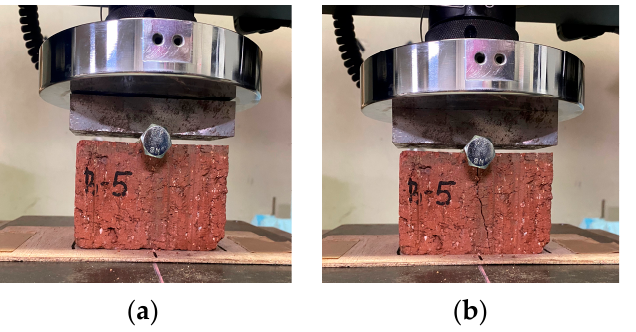
Figure 11. Photo of the dowel-bearing test of brick. ( a ) Specimen before experiment; ( b ) failure of the specimen.